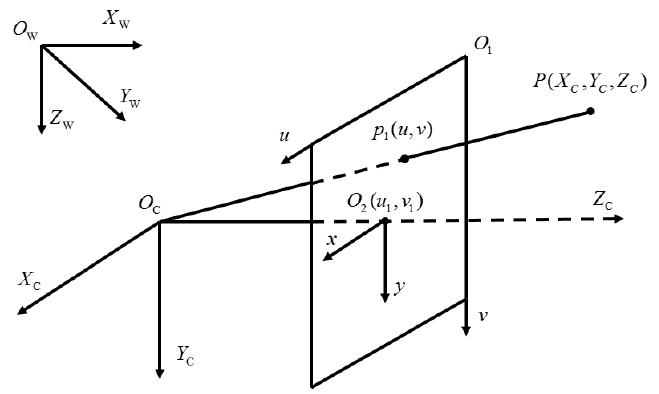
Figure 1. Coordinate system in camera